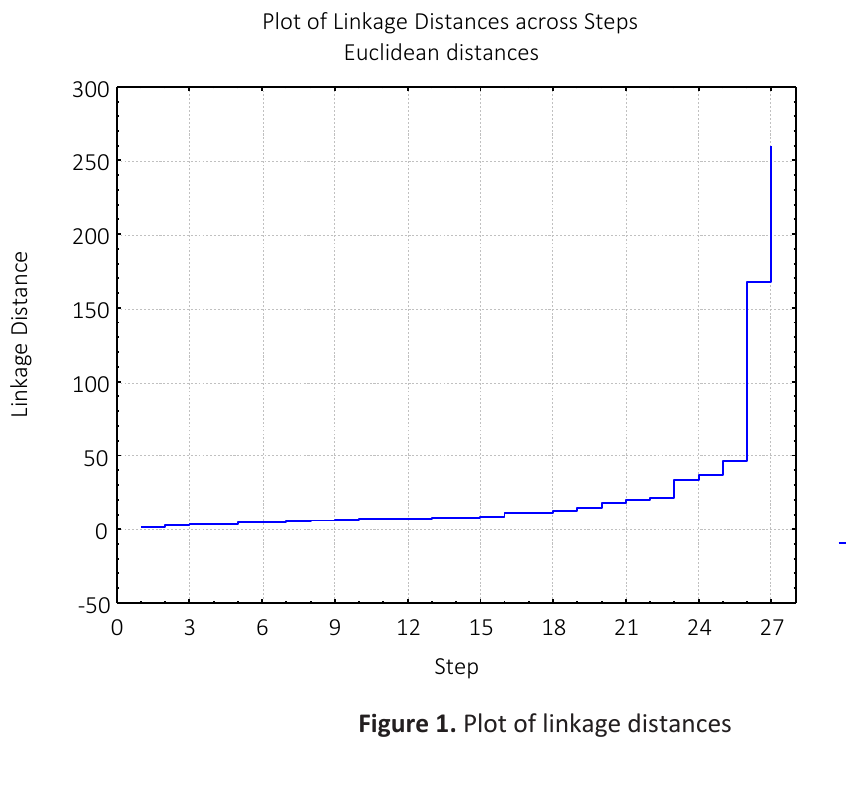
Figure 1. Plot of linkage distances